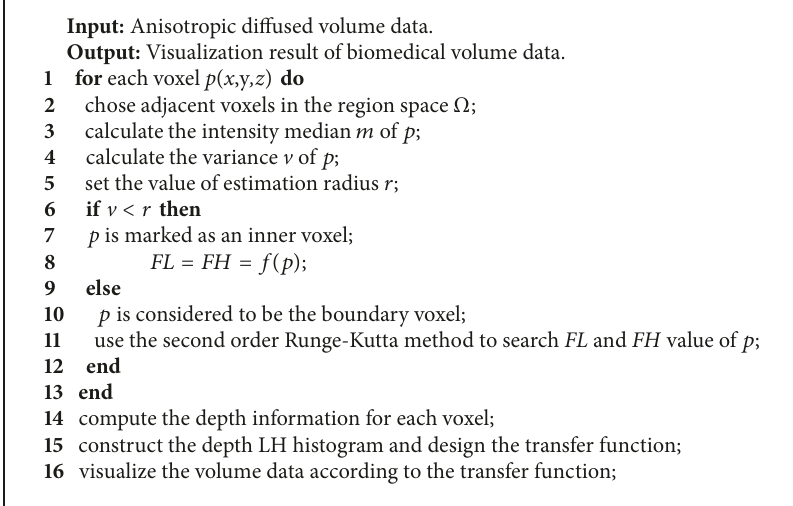
Algorithm 1: Region space guided